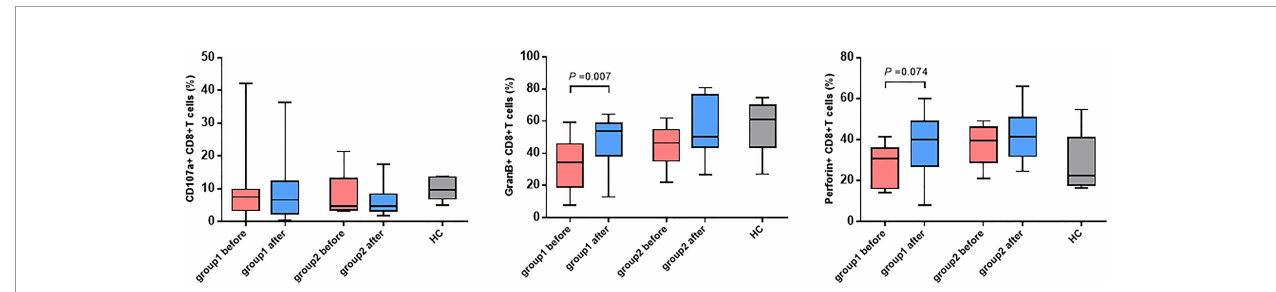
FIGURE 4 | The changes in CD107a, GranB and perforin expressed CD8 + T cells. Expression of CD107a, perforin and GranB on CD8 + T cells before and after childbirth between the group 1 and group